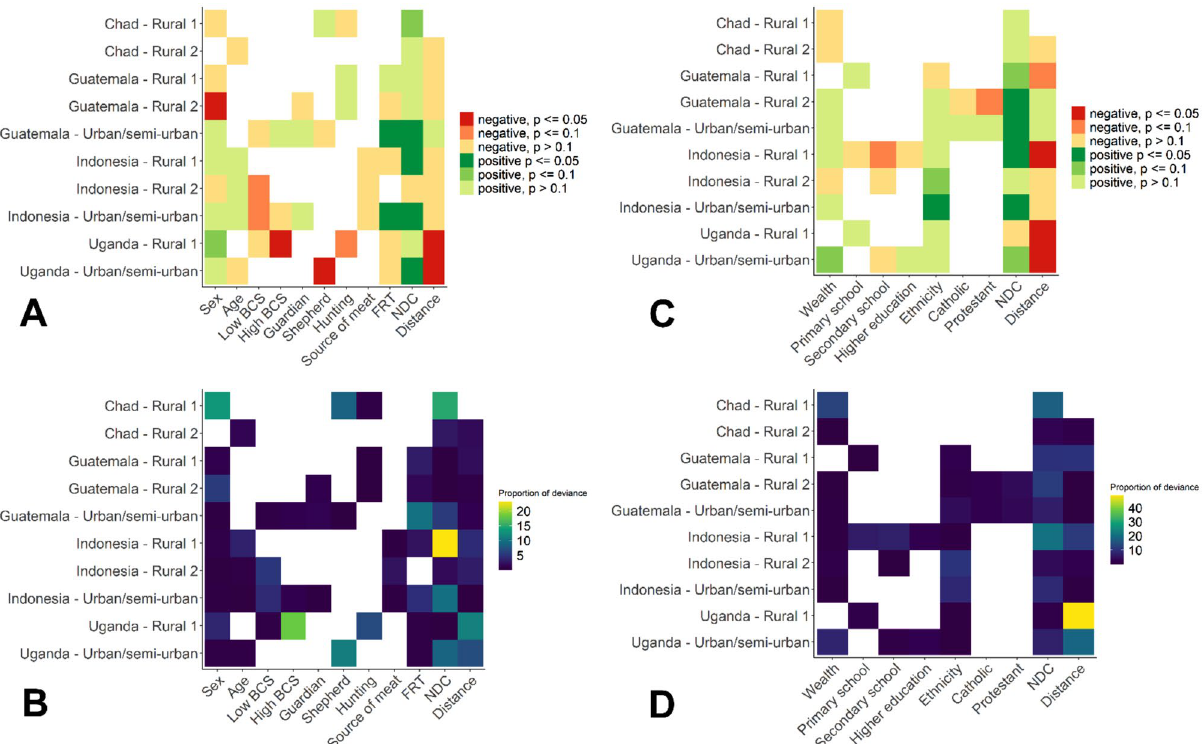
Figure 3. Permutation-based linear model (PBLM) results with degree as response variable. ( A ) Significance and direction of coefficients of the dog-level networks. ( B ) Proportion of deviance of the PBLM explained by each variable in the dog-level networks. ( C ) Significance and direction of coefficients of the household-level networks. ( D ) Proportion of deviance explained by each variable in the household-level networks. Empty field denote variables that were not explored or were not selected for the best models by the PBLM (see methods). Details on the values of the coefficients and p values are presented in the Supplementary Tables S10–S21. Dog-level factors (see also Supplementary Table S3) are: dog’s sex (Sex—0: male (baseline), 1: female); body condition score (BCS) of 2 and lower (Low BCS), BCS of 4 and higher (High BCS) with the baseline of BCS = 3; being a guardian dog (Guardian, dummy variable), hunting dog (Hunting, dummy variable), shepherd dog (Shepherd, dummy variable) or raised for meat (Source of meat, dummy variable); free-roaming time (FRT— range from 0 to 10); number of dogs collared per household (NDC, contiguous variable); and distance per 100 m from dogs home to the centroid of the study site (Distance, continuous variable). Household-level factors (see also Supplementary Table S4) are: wealth category based on the Multiple Factor Analysis or the income when available (Wealth, with the lowest level (i.e. poorest) being the baseline); owner finalizing primary school (Primary school), finalizing secondary school (Secondary school), finalizing professional training or university (Higher Education), with absence of formal education being the baseline; owner belonging to the main local ethnicity (Ethnicity, dummy variable), being catholic (Catholic, dummy variable), being evangelic (Evangelic, dummy variable); number of dogs collared per household (NDC, contiguous variable); and distance per 100 m from household to the centroid of the study area (Distance, continuous